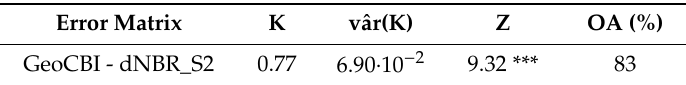
Table 4. Error matrix statistics for the single combination of the ground-based burn index (GeoCBI) and reflectance-based dNBR index derived from Sentinel-2A (dNBR_S2). K represents the unweighted kappa value and v â r(K) the corresponding variance, Z is the score of the Z test statistic, and OA indicates the overall accuracy. Each statistic was computed on the validation dataset (n = 36 plots). See Table S1 for category and ranges of the ground-based burn severity index and Figure 3 for categories and regressed thresholds of the dNBR index. Significance p -values of Z scores are represented as *, **, and *** which correspond respectively to p < 0.05, p < 0.01 and p <